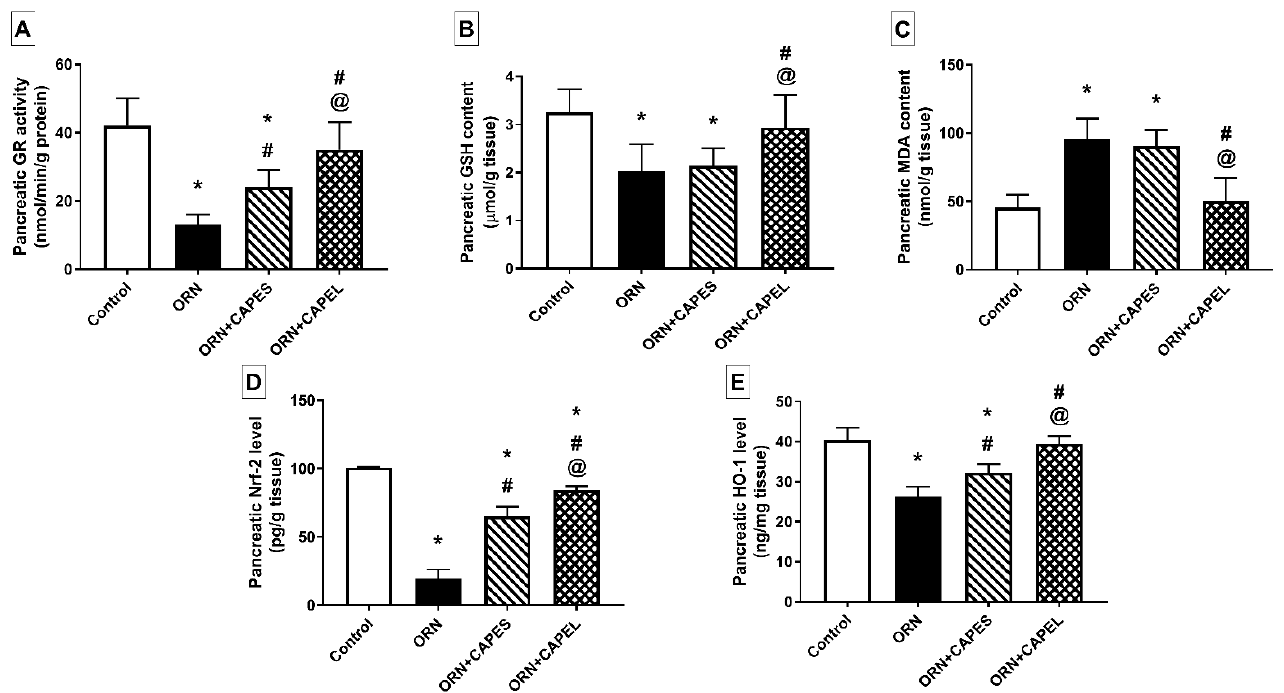
Figure 4. Effect of administering caffeic acid phenethyl ester (CAPE)-optimal liposomal formulation (CAPEL) on pancreatic oxidative status and Nrf2 signaling in rats with ornithine-induced acute pancreatitis. ( A ) Pancreatic glutathione reductase (GR) activity. ( B ) Pancreatic glutathione (GSH) content. ( C ) Pancreatic malondialdehyde (MDA) content. ( D ) Pancreatic nuclear factor erythroid 2-related factor 2 (Nrf2) level. ( E ) Pancreatic heme oxygenase-1 (HO-1) level. Data are expressed as mean ± S.D. ( n = 8). *, # and @ indicate significant difference at p < 0.05 from control, ORN and ORN+CAPES groups, respectively (one-way ANOVA followed by Tukey’s multiple comparisons test). ORN, ornithine; CAPES, free caffeic acid phenethyl ester (CAPE) suspension; CAPEL, caffeic acid phenethyl ester (CAPE)-optimal liposomal formulation.